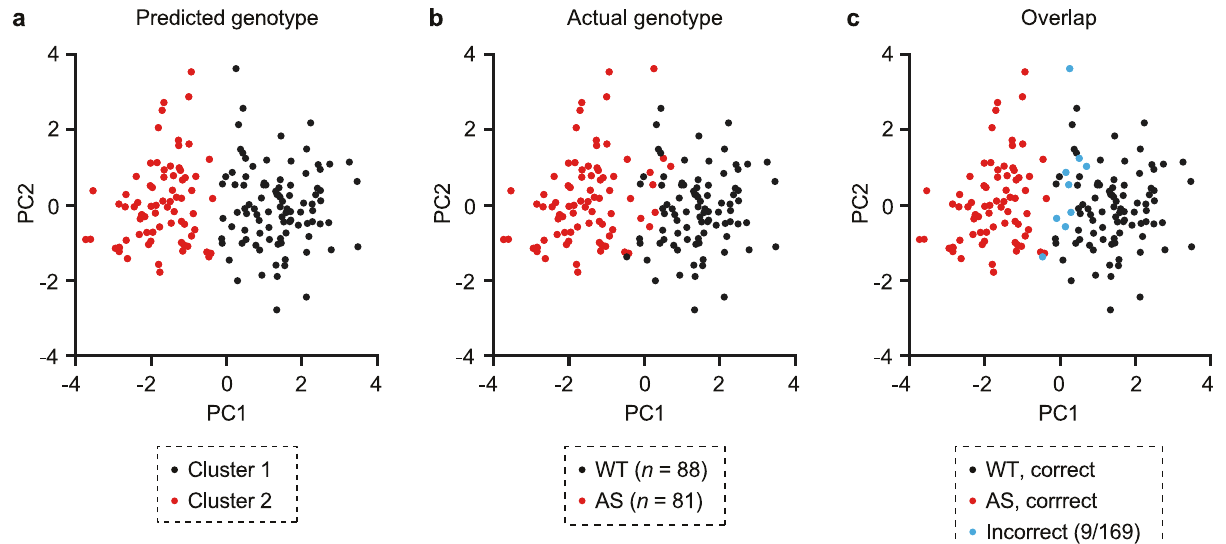
Fig. 2 Multidimensional behavioral analysis predicts Ube3a genotype with high accuracy. a PCA plus k-means clustering categorized two clusters, with each dot representing one mouse ’ s behavioral pro fi le in 2PC space (black: cluster 1, red: cluster 2). b Actual genotype of animals (black: WT, red: AS). c An overlay of a , b with animals clustered incorrectly labeled in blue. Clustering accuracy was